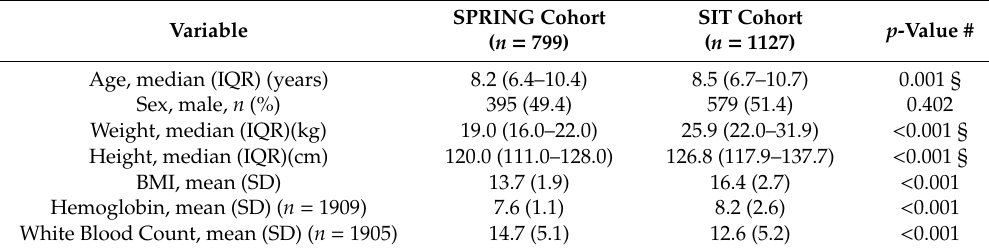
Table 1. Baseline characteristics of children with sickle cell anemia (SCA) aged 5–12 years old living in northern Nigeria and screened for the Primary Stroke Prevention in Nigeria (SPRING) trial ( n = 799) compared to high-income countries (Silent Cerebral Infarct Multi-Center Clinical (SIT) cohort; n = 1127).